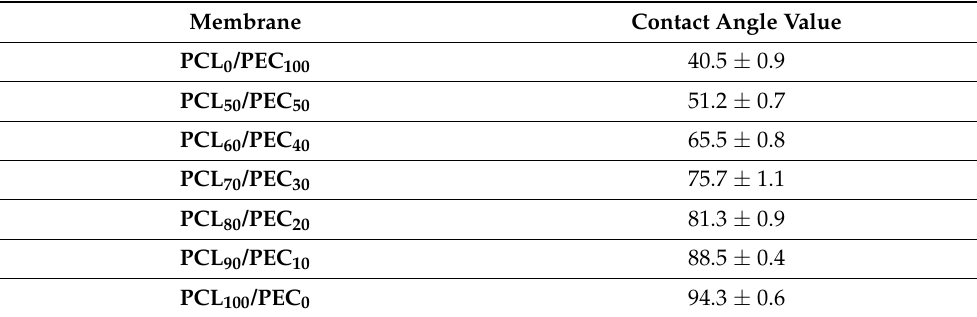
Table 4. Contact angle values measured for all materials obtained. Values were obtained using milliQ water as a solvent, from the media of six measures.